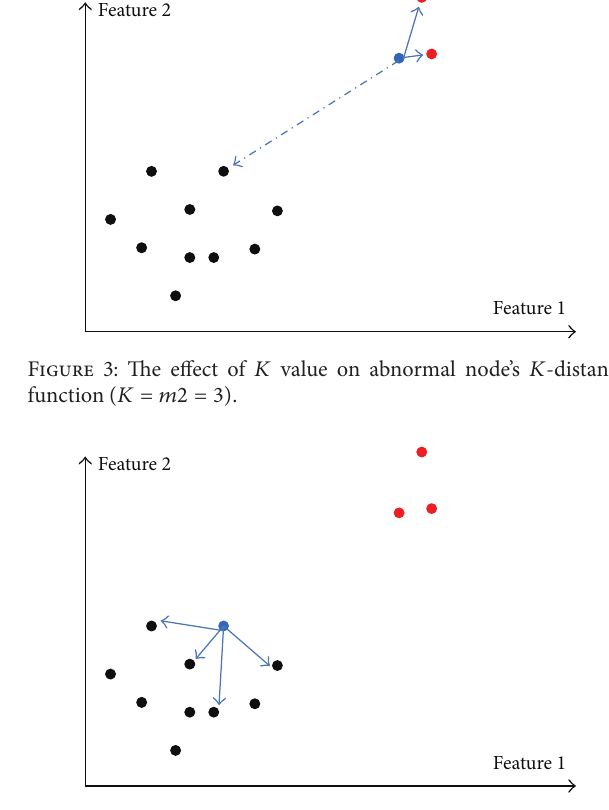
Figure 4: The effect of 𝐾 value on normal node’s 𝐾 -distance function (𝐾 = 4 < 𝑚1)